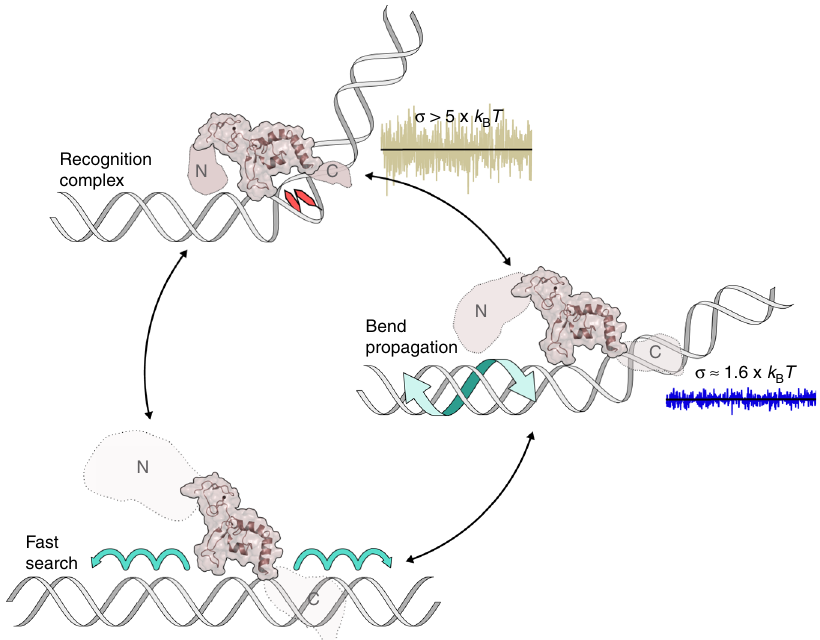
Fig. 7 Working model of XPA linear diffusion on DNA. Fast search (long-range linear diffusion): monomeric XPA translocates rapidly by hopping (micro- associations/dissociations) along the DNA backbone. The protein ’ s disorder and lack of contacts with DNA permit rapid diffusion ( D ≈ 0.04 μ m 2 /s). Bend propagation (short-range linear diffusion): XPA follows the path of the major or minor groove, spiraling along DNA ( D ≈ 0.003 μ m 2 /s). The N- and C- termini of the protein may be partially folded, making more contacts with the DNA. The protein bends DNA, testing for fl exibility/aberrations, and propagation of the bend further slows diffusion. Recognition complex (paused and stationary particles): the disordered ends of the protein fold into a stable complex, bending the DNA ∼ 60°. The NMR structure of the XPA DNA-binding domain (PDB 1XPA) was used in combination with an estimation for the N- and C-termini (disorder represented by size/transparency) as an approximate model to display the complete XPA